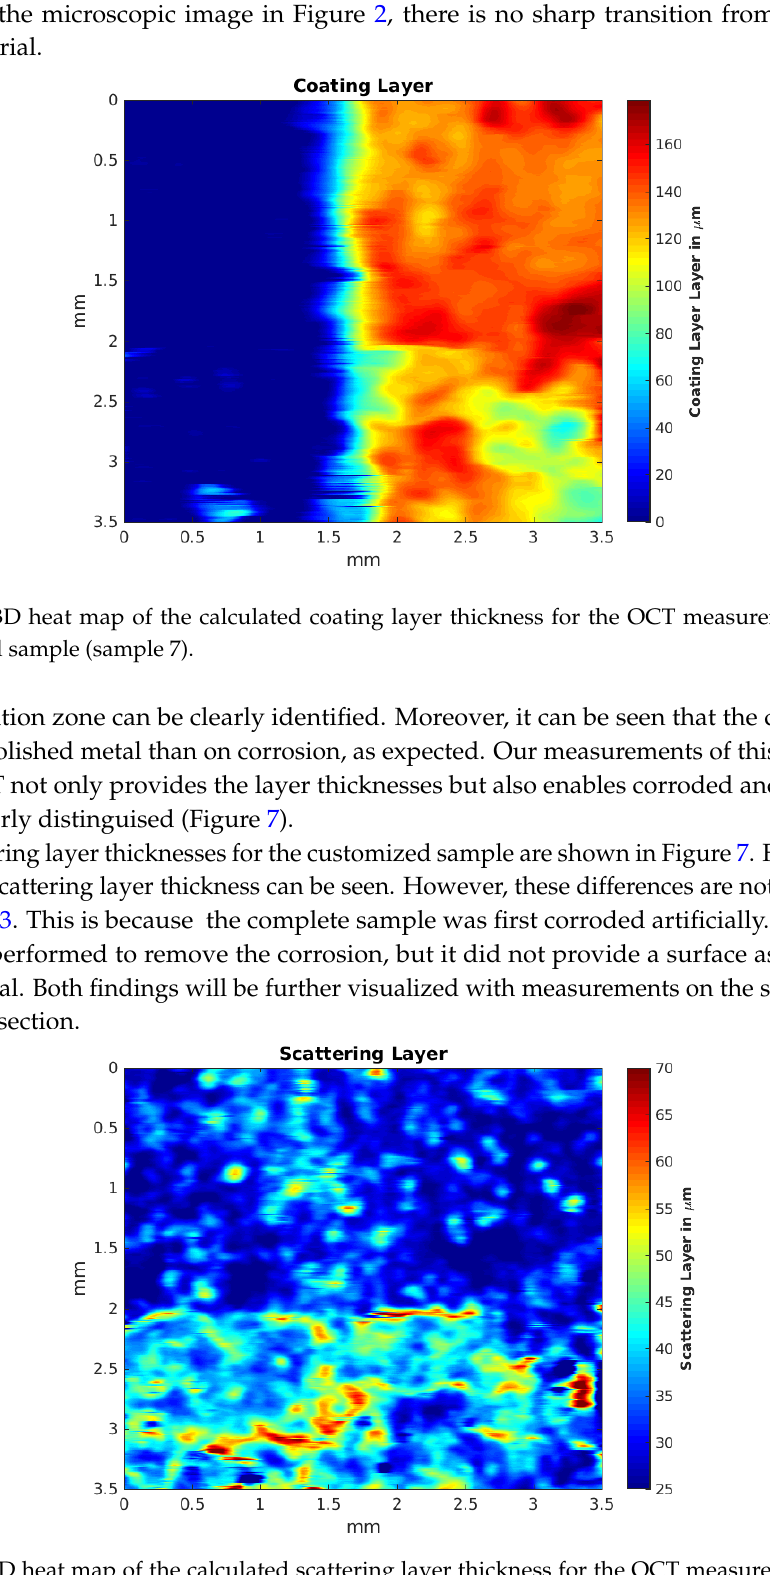
Figure 7. 3D heat map of the calculated scattering layer thickness for the OCT measurement of the customized sample (sample